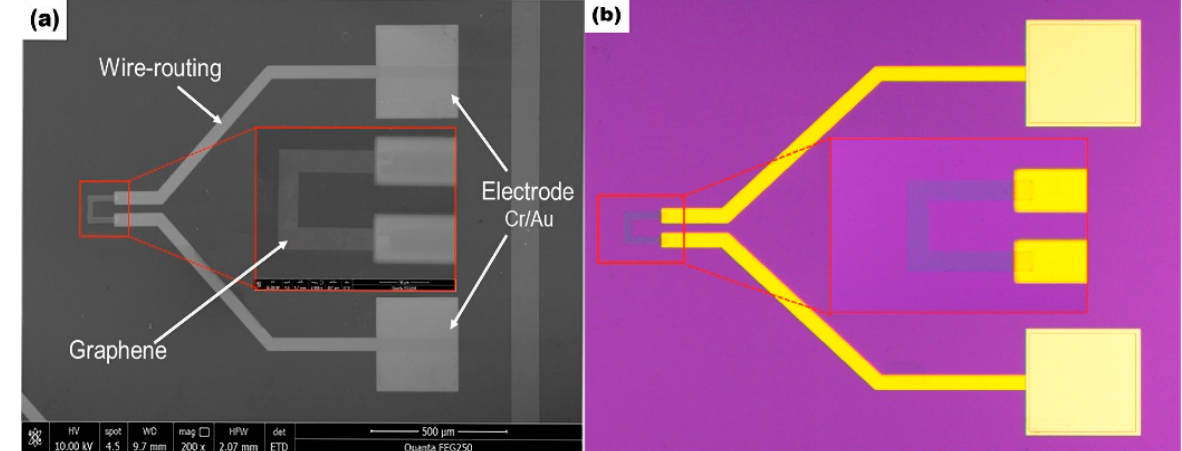
Figure 5. ( a ) SEM image of the chip. ( b ) Optical microscope image of the chip.